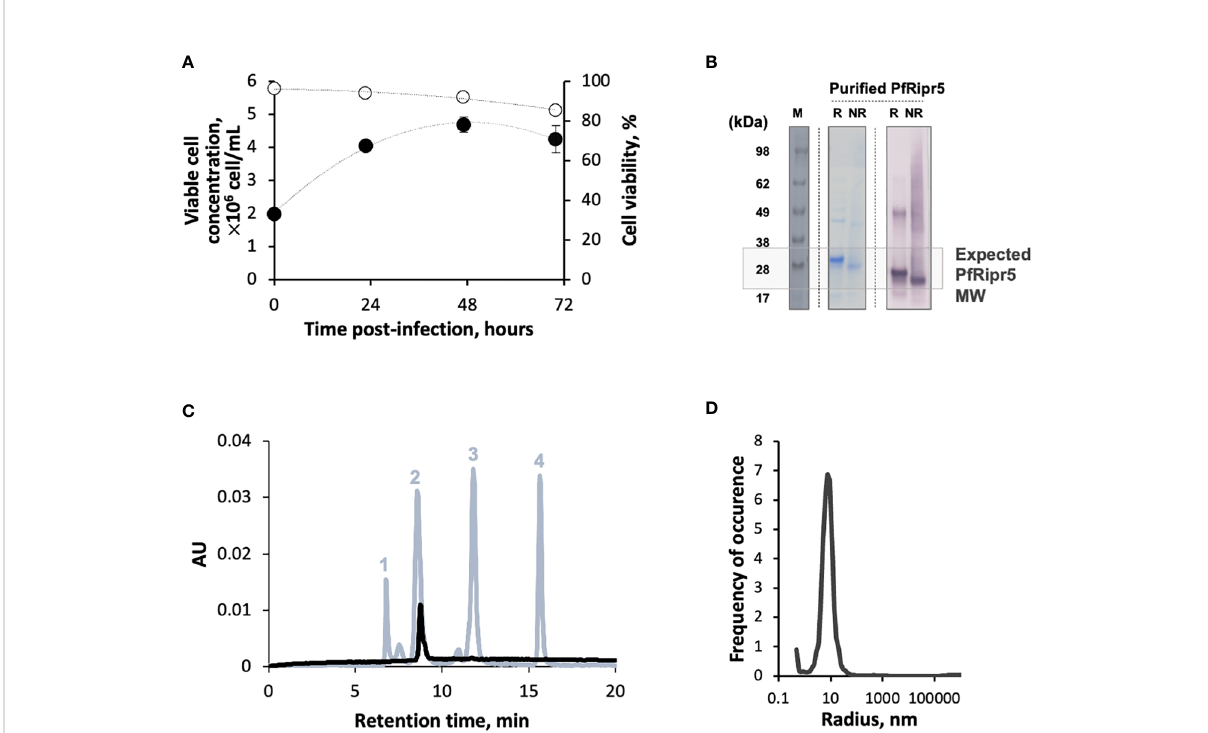
FIGURE 1 Production and characterization of PfRipr5. (A) Viable cell concentration ( fi lled circles) and cell viability (open circles) throughout production process. (B) Identi fi cation of PfRipr5 by SDS-PAGE (middle panel) and Western blot (right panel) in puri fi ed sample. M denotes pre-stained protein standard SeeBlue ® Plus2, R denotes reduced sample, NR denotes non-reduced sample. (C) HPLC-SEC analysis of puri fi ed PfRipr5 protein (black line). The protein standard mix (grey line) used for estimation of PfRipr5 molecular weight was composed by (1) thyroglobulin (660 kDa), (2) ovalbumin (44.2 kDa), (3) ribonuclease A (13.7 kDa), and (4) uracil (112 Da). AU denotes absorbance unit (280 nm). (D) Size distribution pro fi le of puri fi ed PfRipr5 assessed by dynamic light scattering (average of three measurements). A representative data of one biological replicate (n = 1) was